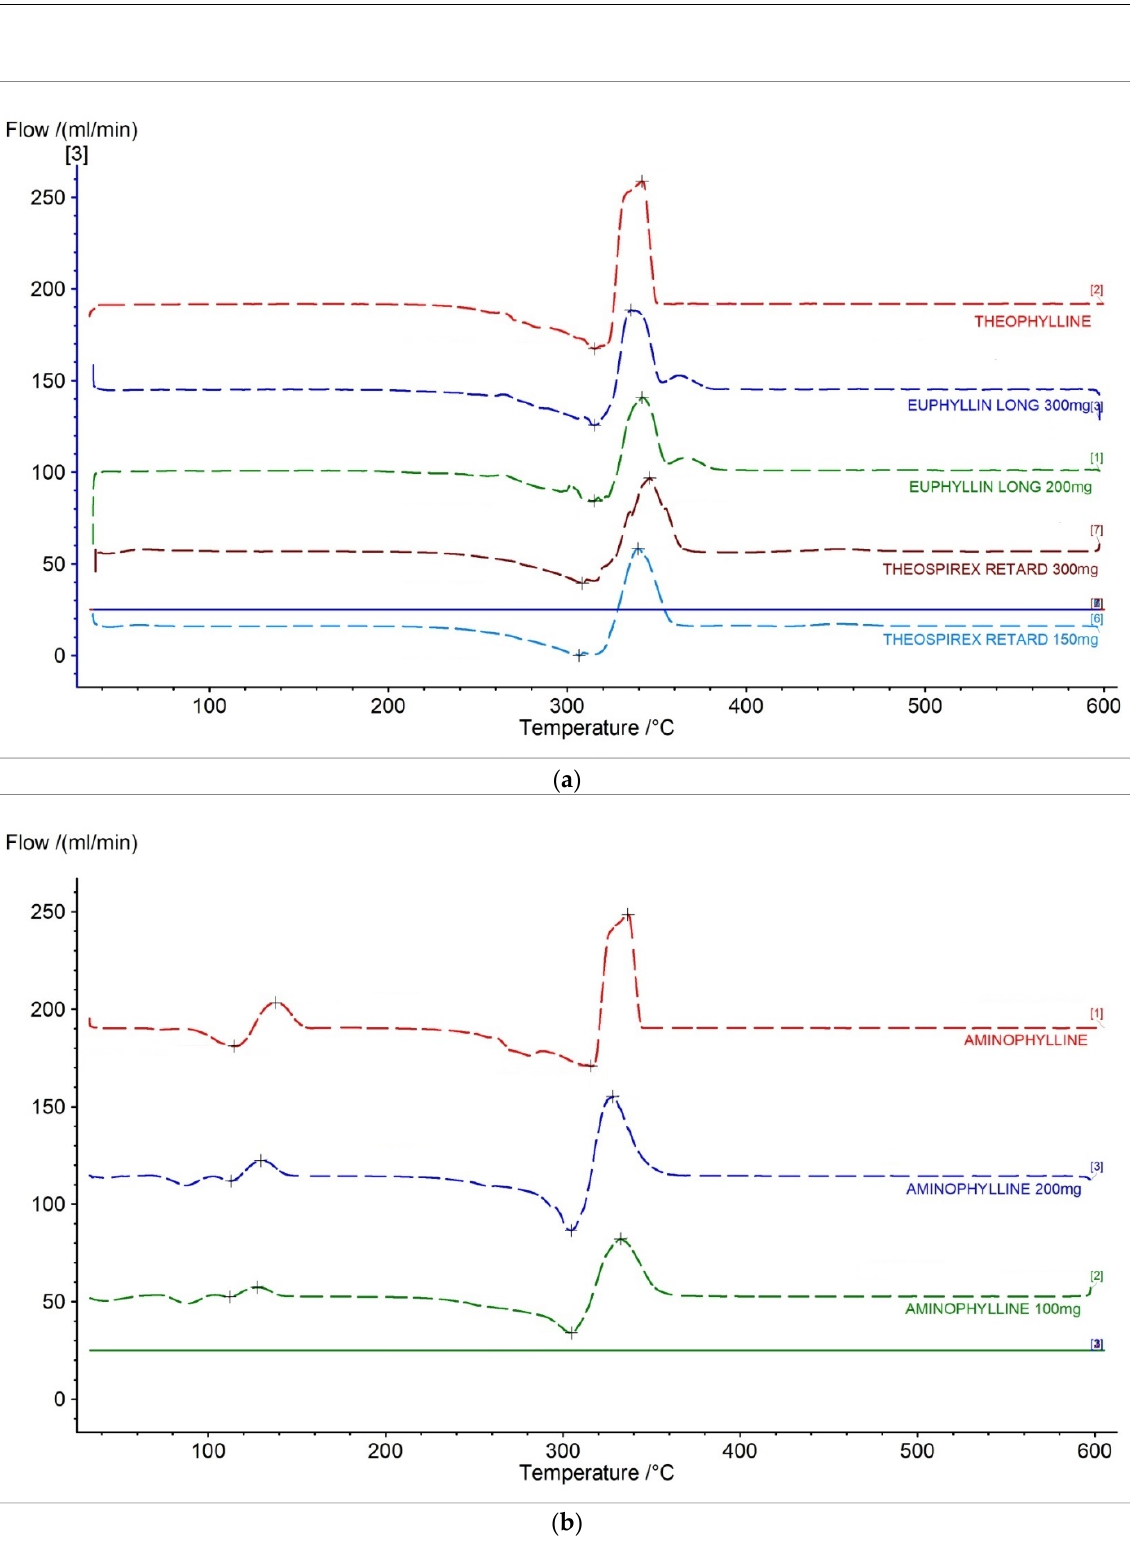
Figure 4. D2TG curves for ( a ) theophylline standard, ( b ) aminophylline standard and pharmaceutical preparations containing theophylline, and aminophylline.